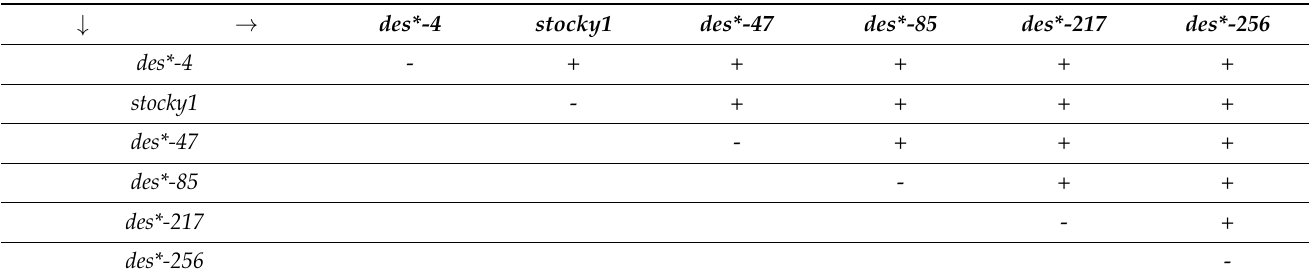
Table 2. Results of the complementation test of the des* mutants crossed inter se. (+) and ( − ) indicate complementation and non-complementation,